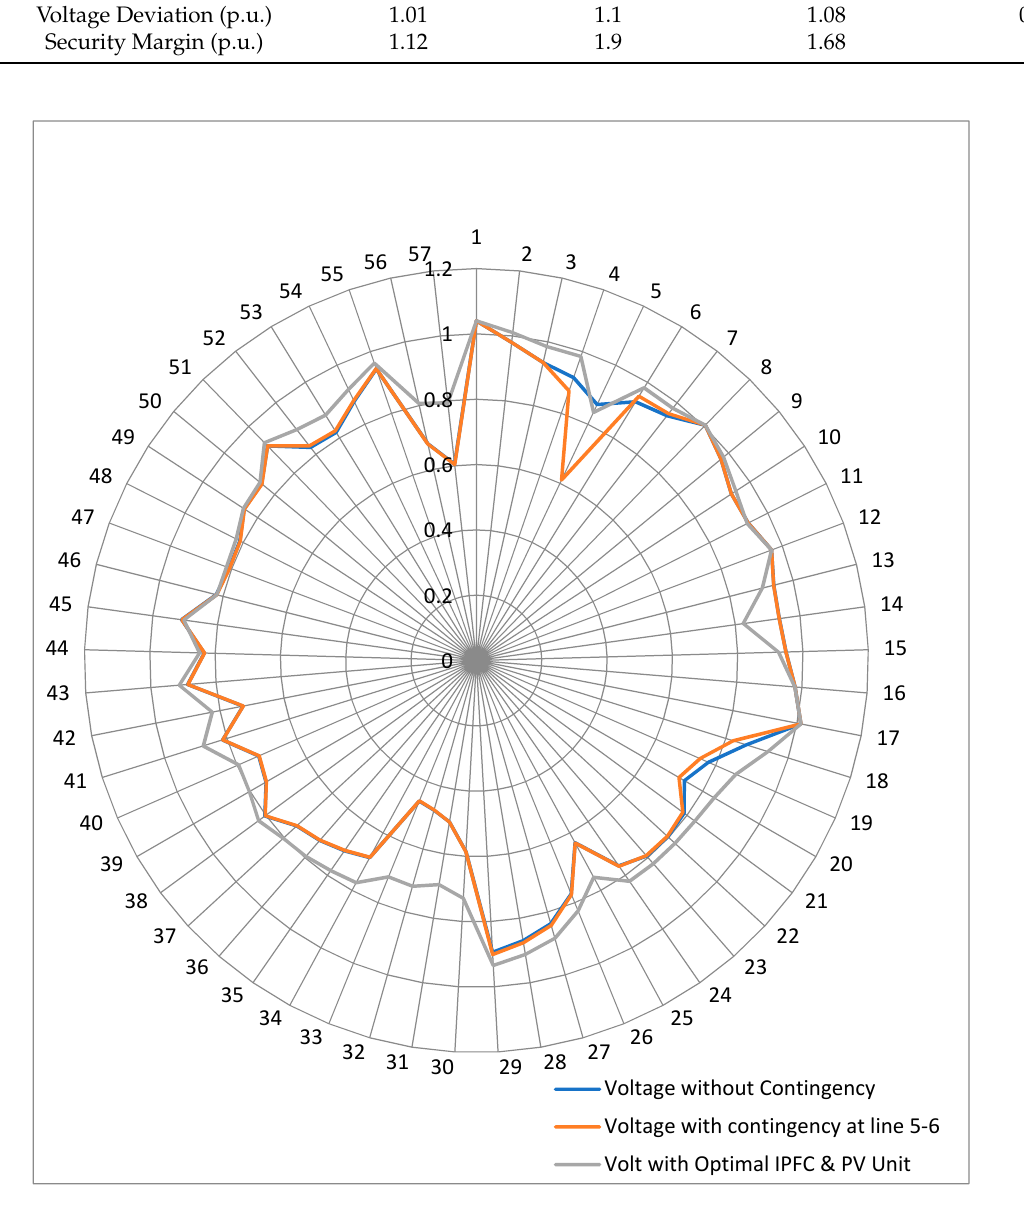
Figure 13. Voltage profile of the IEEE 57 bus system under various stages of operation.